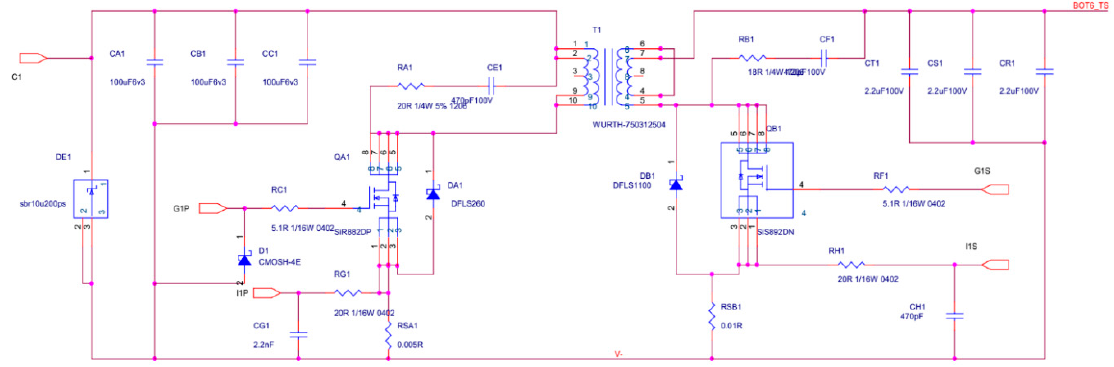
Figure 10. Bidirectional equilibrium schematic.